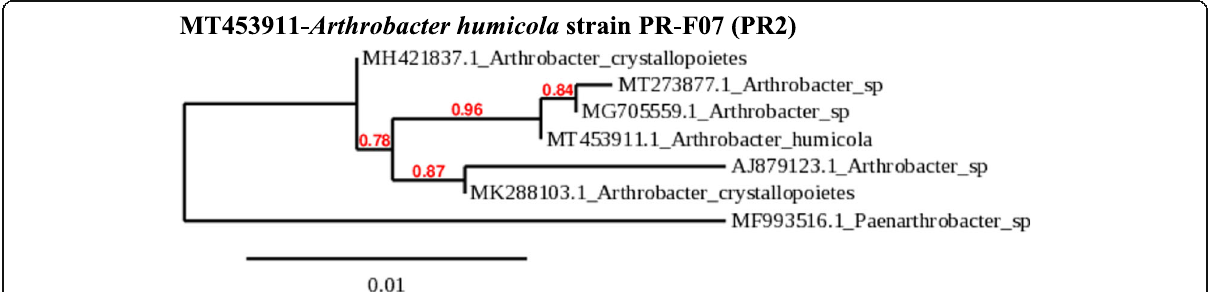
Fig. 2 Neighbor-joining tree showing the phylogenetic relationships of 16S rRNA gene sequences of A. humicola . The scale bar indicates evolutionary distance